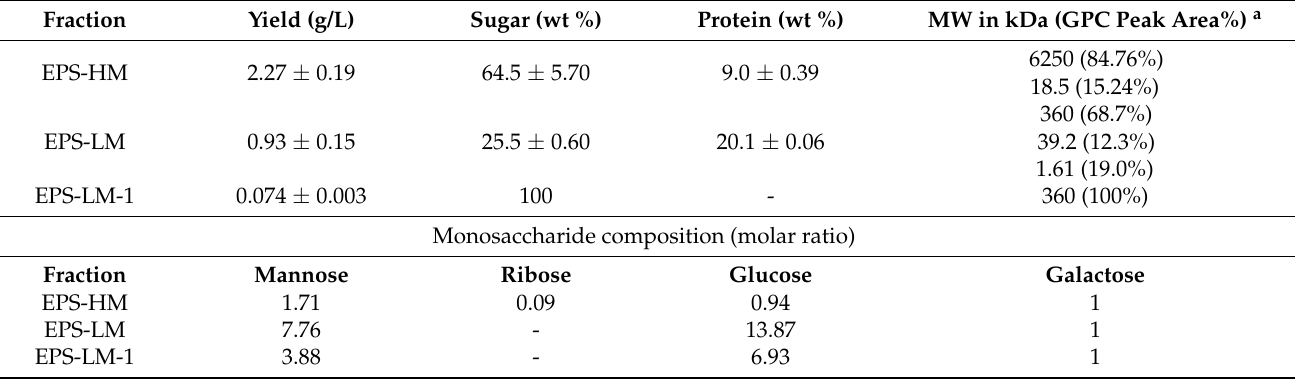
Table 1. Yield and composition of exopolysaccharide (EPS) fractions isolated from the Cs-HK1 fermentation medium by two-step ethanol precipitation and further fraction of EPS-lower MW (LM). HM, higher MW. a . Original GPC results shown in Supplemental Data Figure